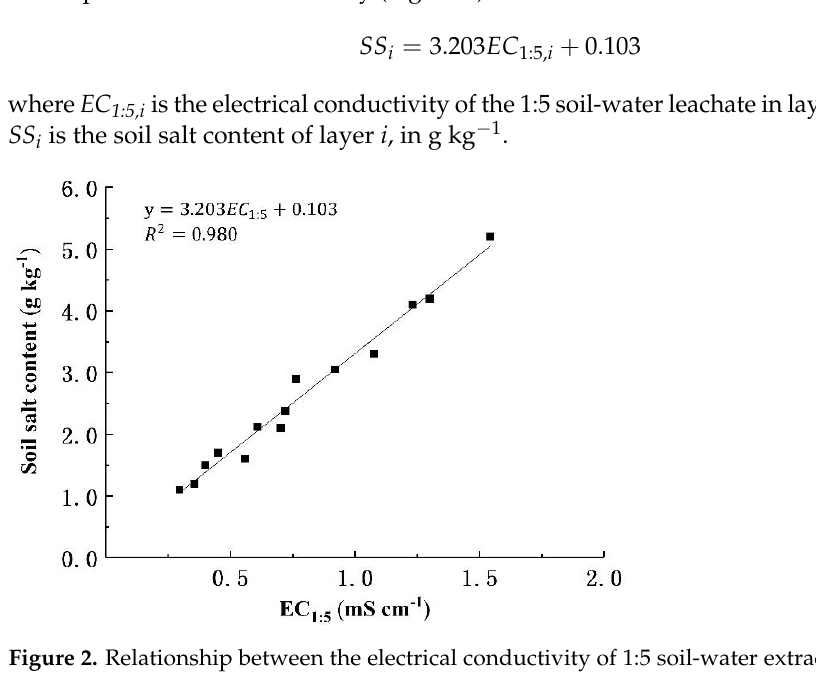
Figure 2. Relationship between the electrical conductivity of 1:5 soil-water extract ( EC 1:5 ) and soil salt content.